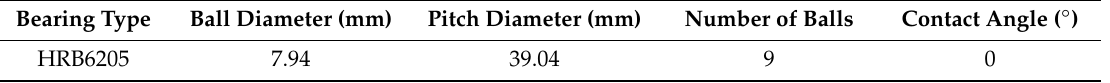
Table 2. Parameters of rolling bearing.